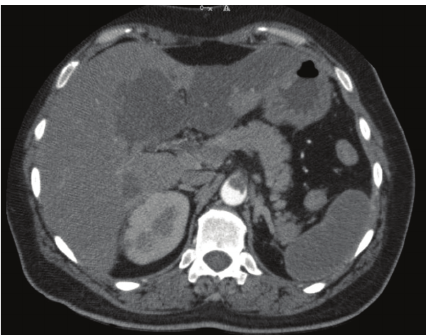
Figure 1: Celiac trunk is obstructed 100% and SMA is obstructed 80%; there are hypodense areas on the liver and the spleen.